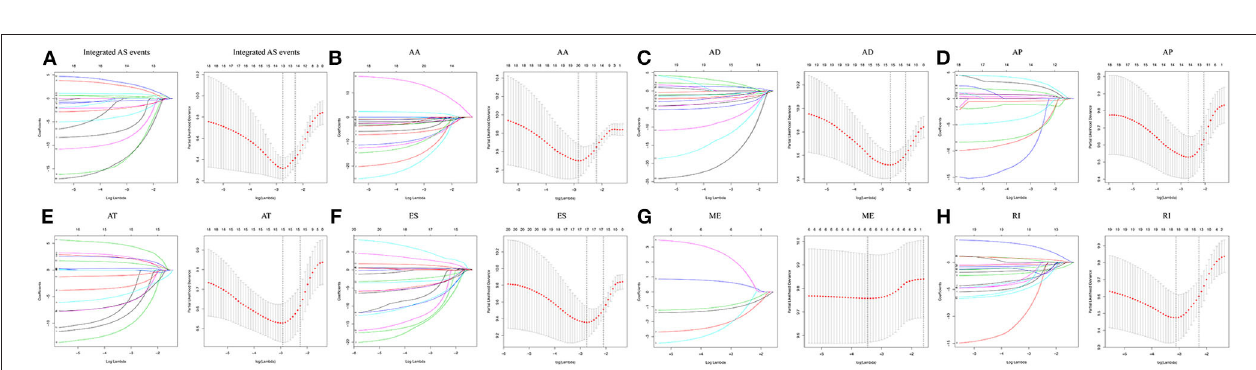
FIGURE 2 | Prognosis-related AS events in GBM. (A) Volcano plot showing an overview of the prognosis-related AS events. (B–H) The top 20 prognosis-related AS events, illustrated by bubble plots, for AA, AD, AP, AT, ES, ME, and RI (z-score > 0, HR > 1; z-score < 0, HR < 1).